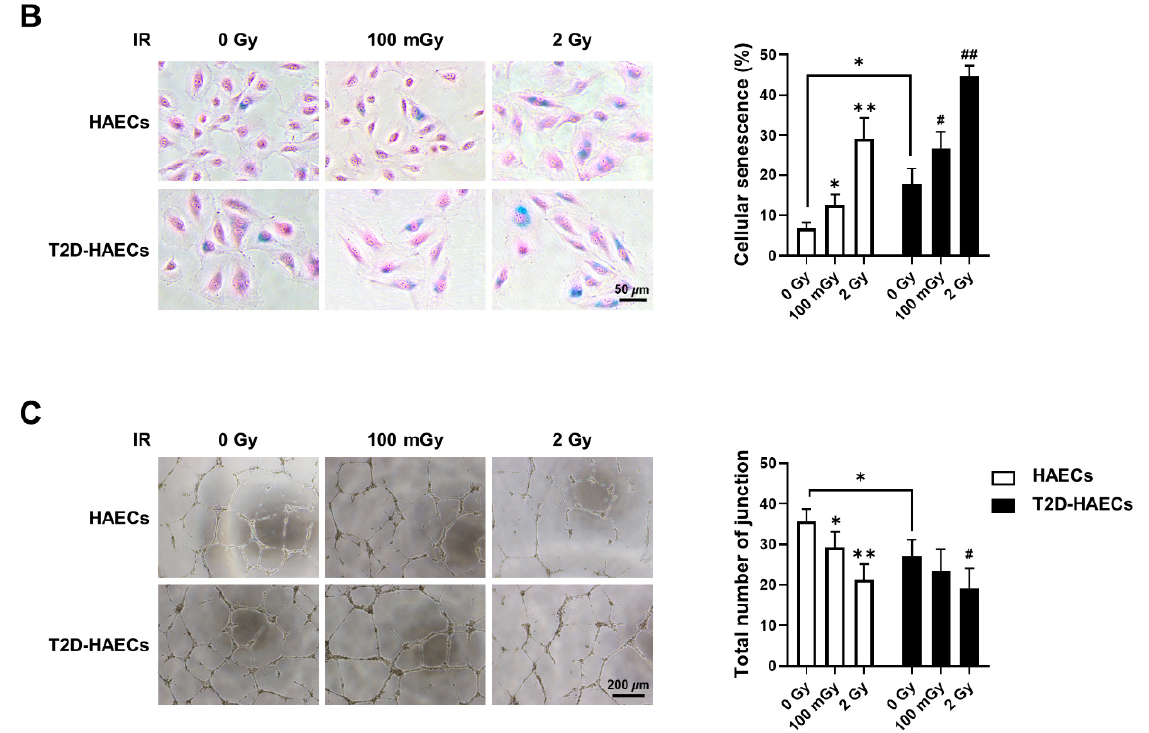
Figure 7. Evaluation of cell proliferation rate, cellular senescence, and tube formation in HAECs and T2D-HAECs after 100 mGy or 2 Gy of ionizing radiation treatments. ( A ) Representative images of cultured HAECs and T2D-HAECs. The proliferative rate of HAECs and T2D-HAECs was measured using an MTT assay (n = 4). ( B ) β -galactose staining and quantification in HAECs and T2D-HAECs. Blue represents β -galactose-positive staining (n = 3). ( C ) Images of tube formation in HAECs and T2D-HAECs 16 h after seeding 1.5 × 10 4 cells/100 µ L. The length and the number of junctions in the tubes were counted and compared in each group (n = 4). All data represent the mean ± SD of three or four independent experiments; * p < 0.05, ** p < 0.01 vs. non-irradiated HAECs. # p < 0.05, ## p < 0.01 vs. non-irradiated